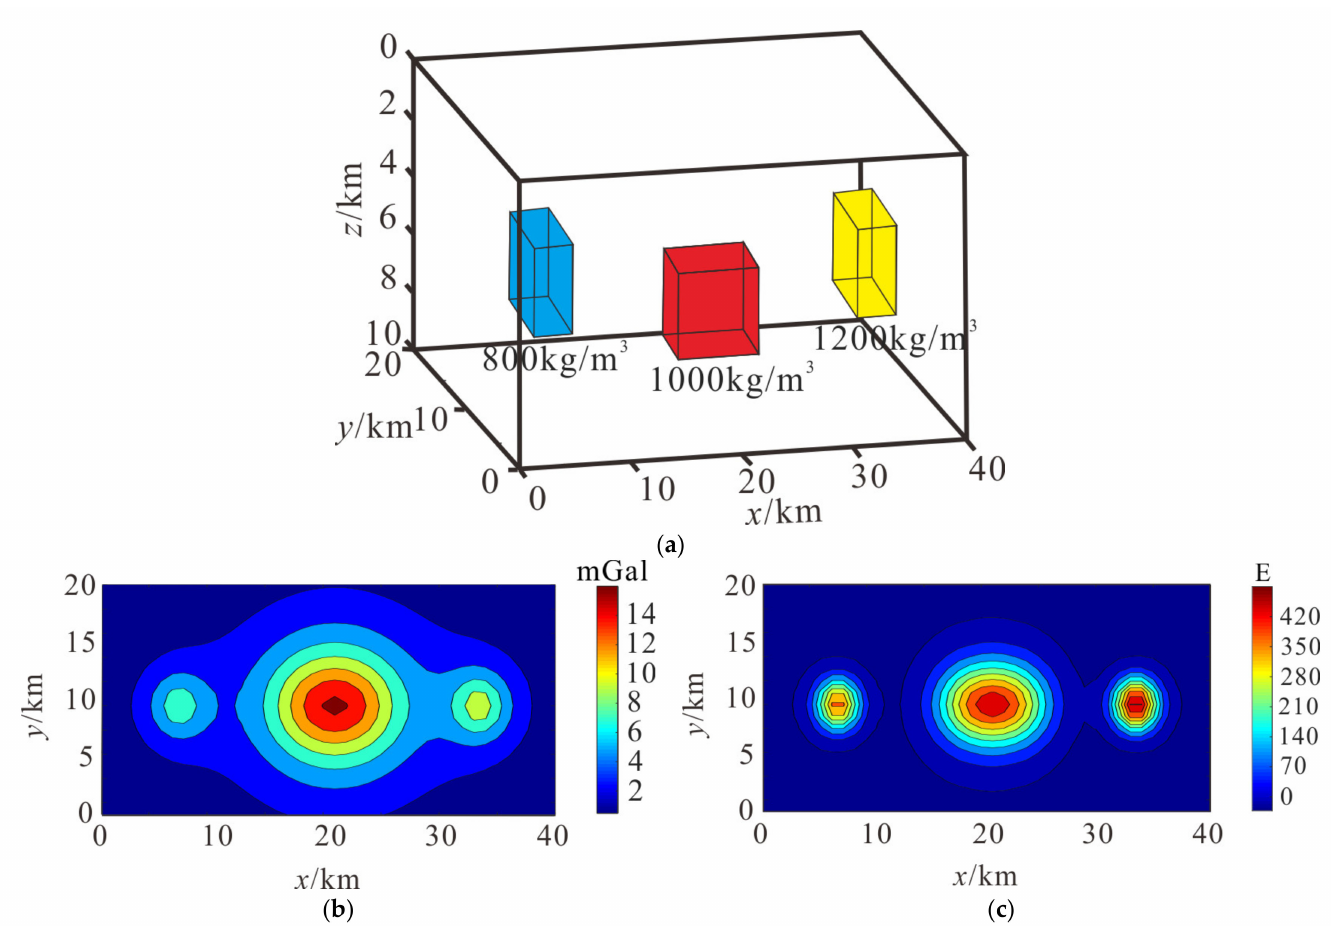
Figure 8. Information of complex models. ( a ) Density models with 1000 kg/m 3 . ( b ) Airborne gravity anomaly at 100 m altitude. ( c ) Vertical gradient anomaly of airborne gravity at 100 m